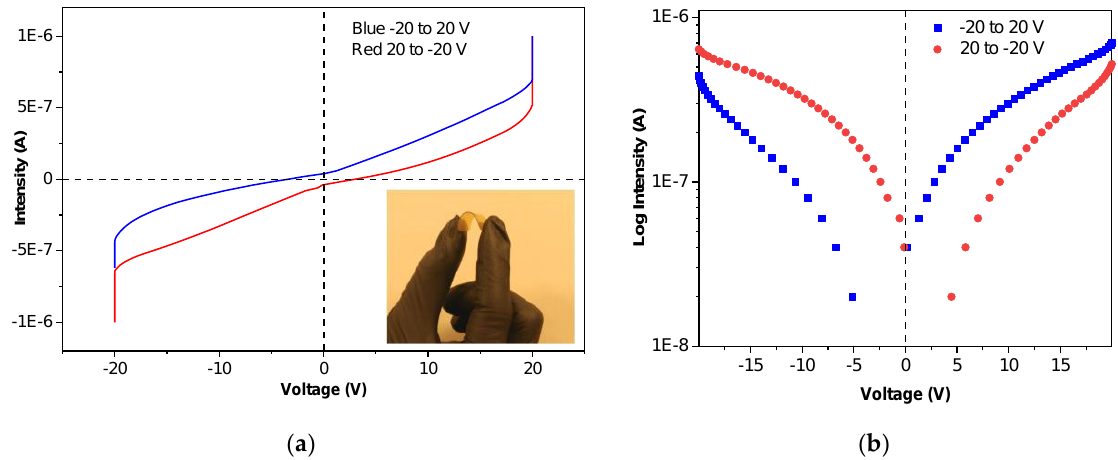
Figure 7. ( a ) Current intensity–voltage (I-V) curves (inset: SPI film flexibility) and ( b ) log I-V curves of SPI films.